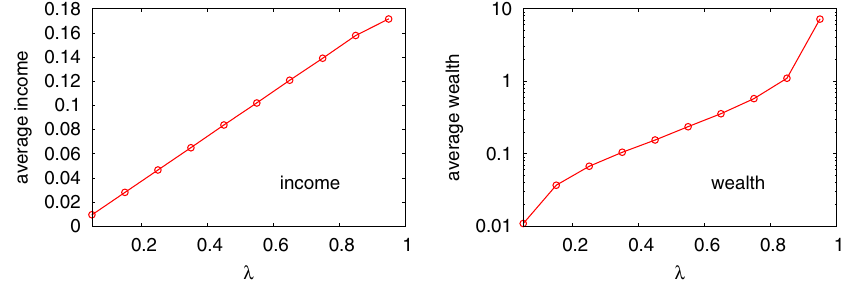
Fig. 5. For distributed saving propensities, the average income and wealth are plotted against di®erent saving propensities in the society. It shows that for higher (cid:1) the income and as well as the accumulated wealth increase.